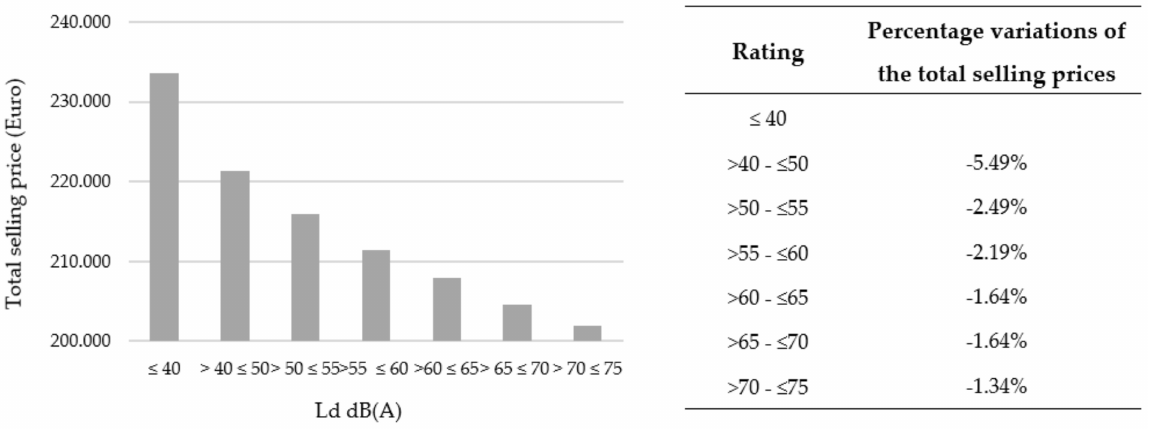
Figure 9. Functional relationship between the Ld label and the prices and percentage variations for the noise pollution class rating for the OMI peripheral area of the city of